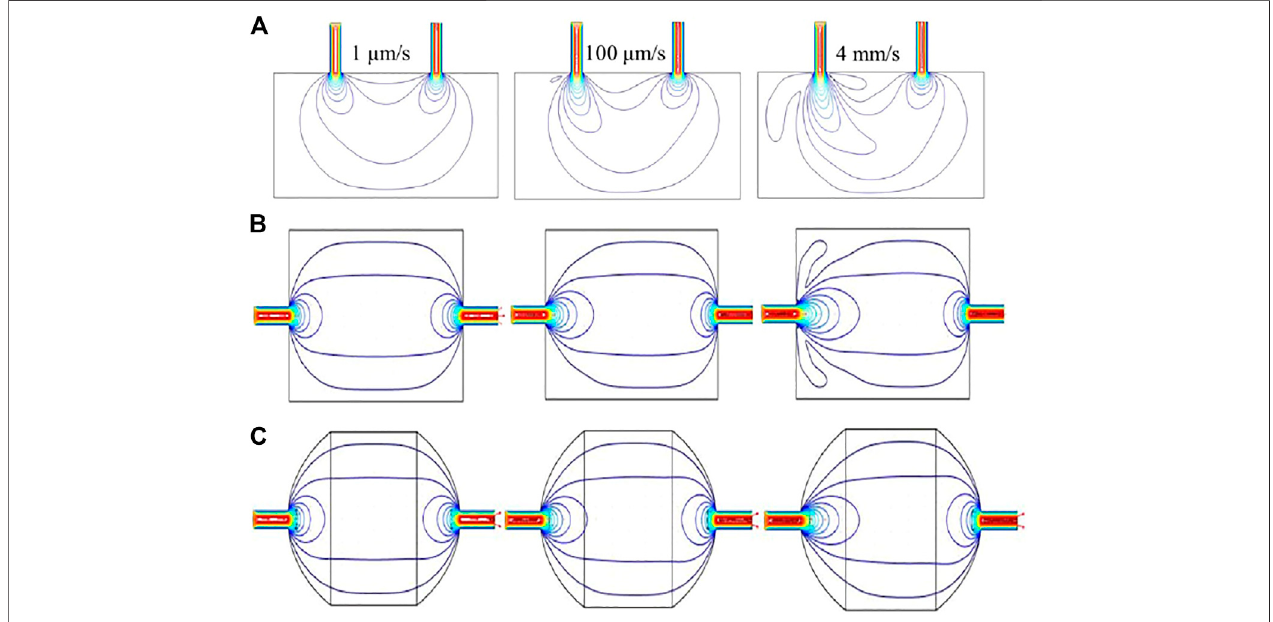
FIGURE7| Results ofCFD simulationin (A) squarechamber (inletand outlet areon thesameside), (B) squarechamber (inletand outlet areon each side),and (C) elliptical chamber (inlet and outlet are on each side).